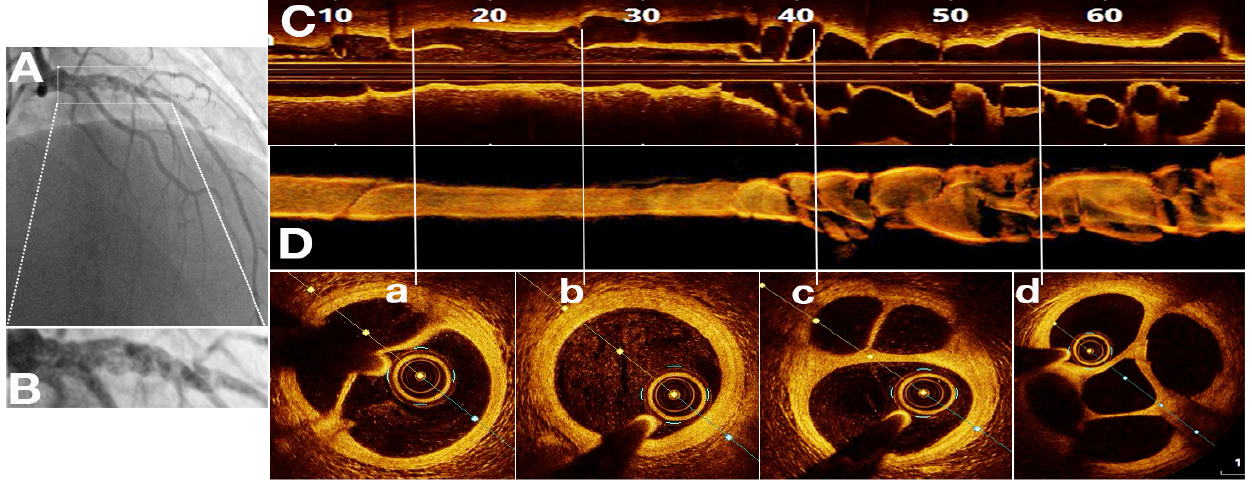
Figure 7. SRCT in a 41 years old male patient with anterior ST elevation myocardial infarction. A —coronary angiography—braided filling defects on proximal and mid left anterior descending artery; B —detailed angiographic view; C —OCT—longitudinal view of SRCT; D —OCT—3D reconstruction longitudinal view of SRCT; a – d OCT—transversal views of SRCT with no signs of atherosclerosis, with possible SCAD etiology. Conservative treatment was applied, due to the scarred myocardium .